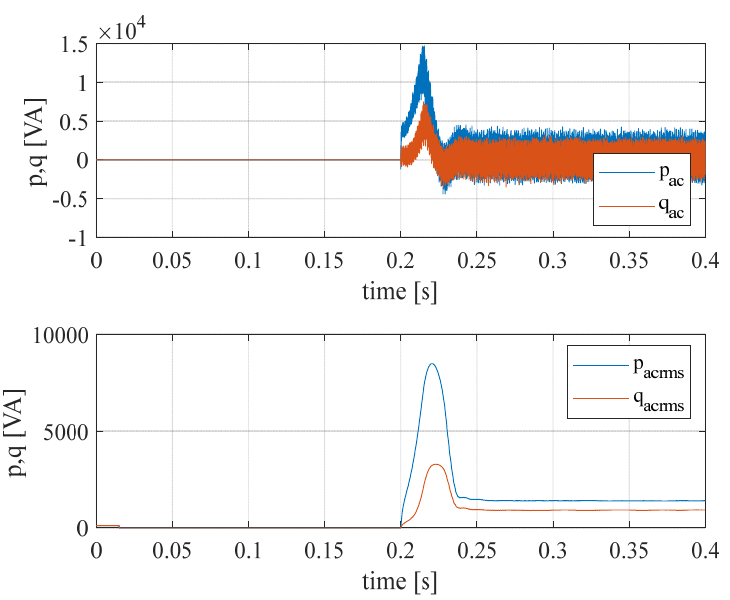
Figure 19. AC components of power during parallel cooperating of both PMSM motor and ICE engine with dumper.